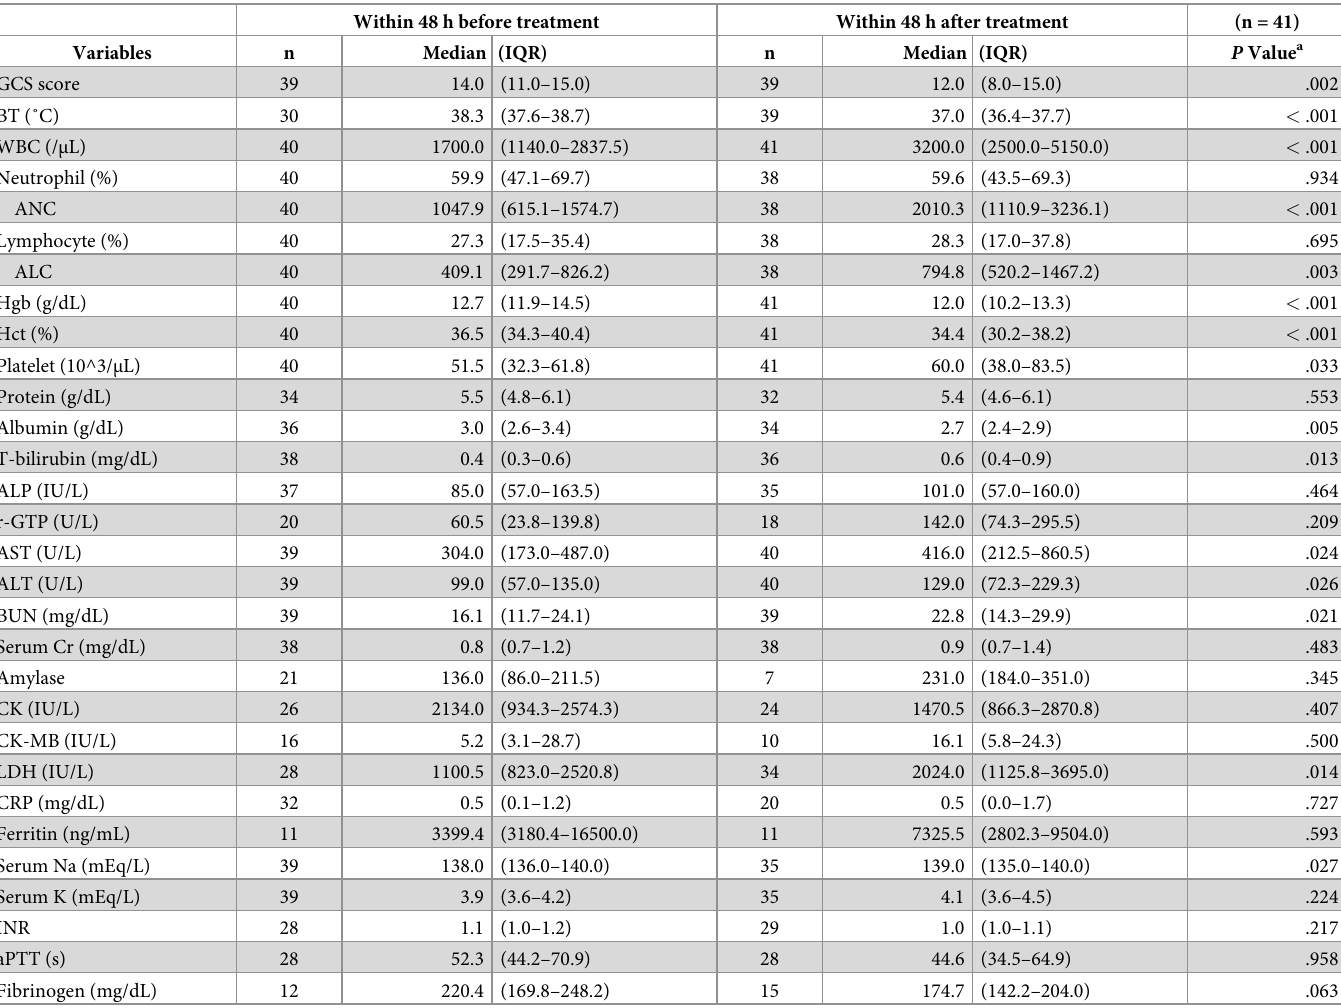
Table 3. Comparison of Clinical and Laboratory Parameters in Patients with SFTS Within 48 Hours Before and After Steroid Treatment. Within 48 h before treatment Within 48 h after